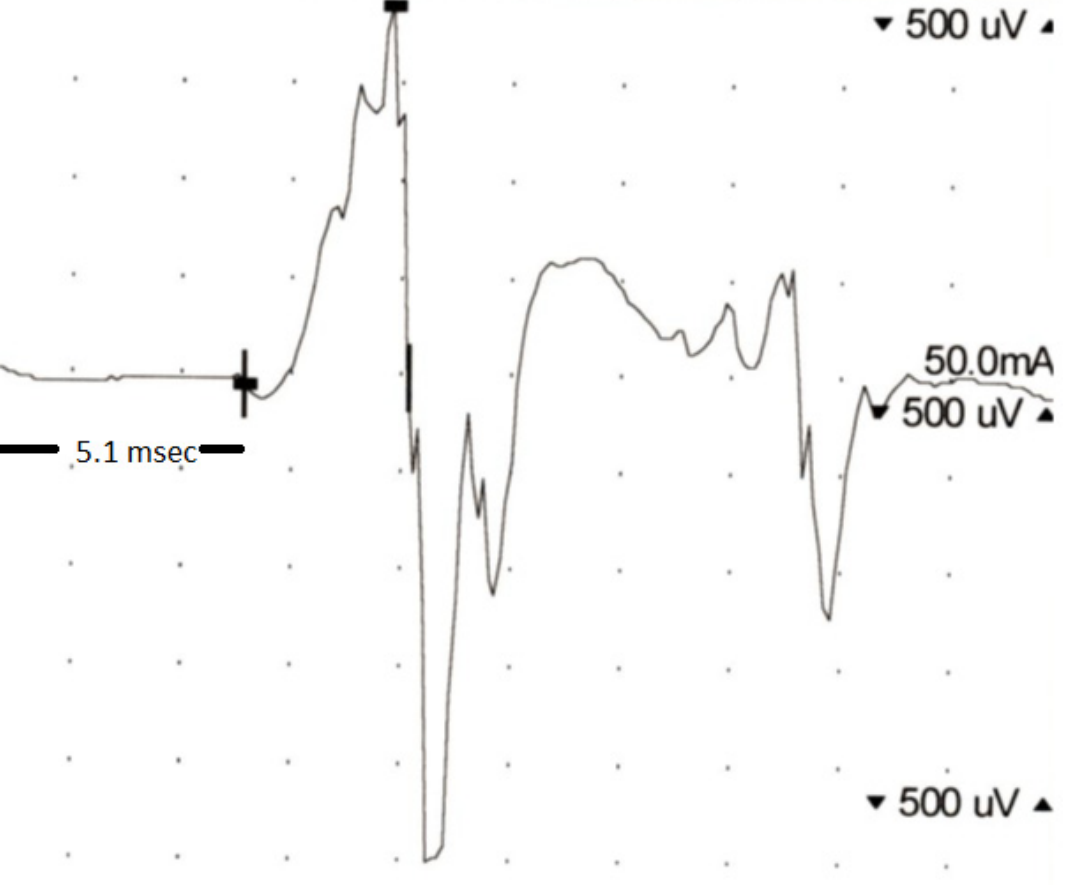
Figure 1. Latency of 5.1 ms (>4.0 ms) in electroneurography (nerve conduction test) of the facial nerve.